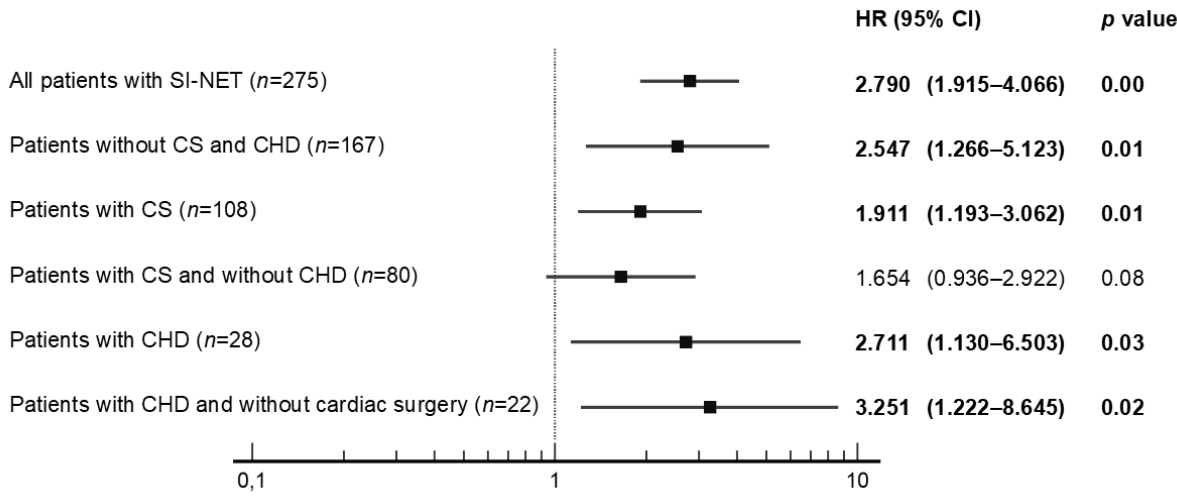
Figure 2. Univariate analysis of primary tumor resection (no vs. yes) with hazard ratios (HR) in all patients with SI-NET. Abbreviations: CHD, carcinoid heart disease; CS, carcinoid syndrome; SI-NET, neuroendocrine tumor of the small intestine.